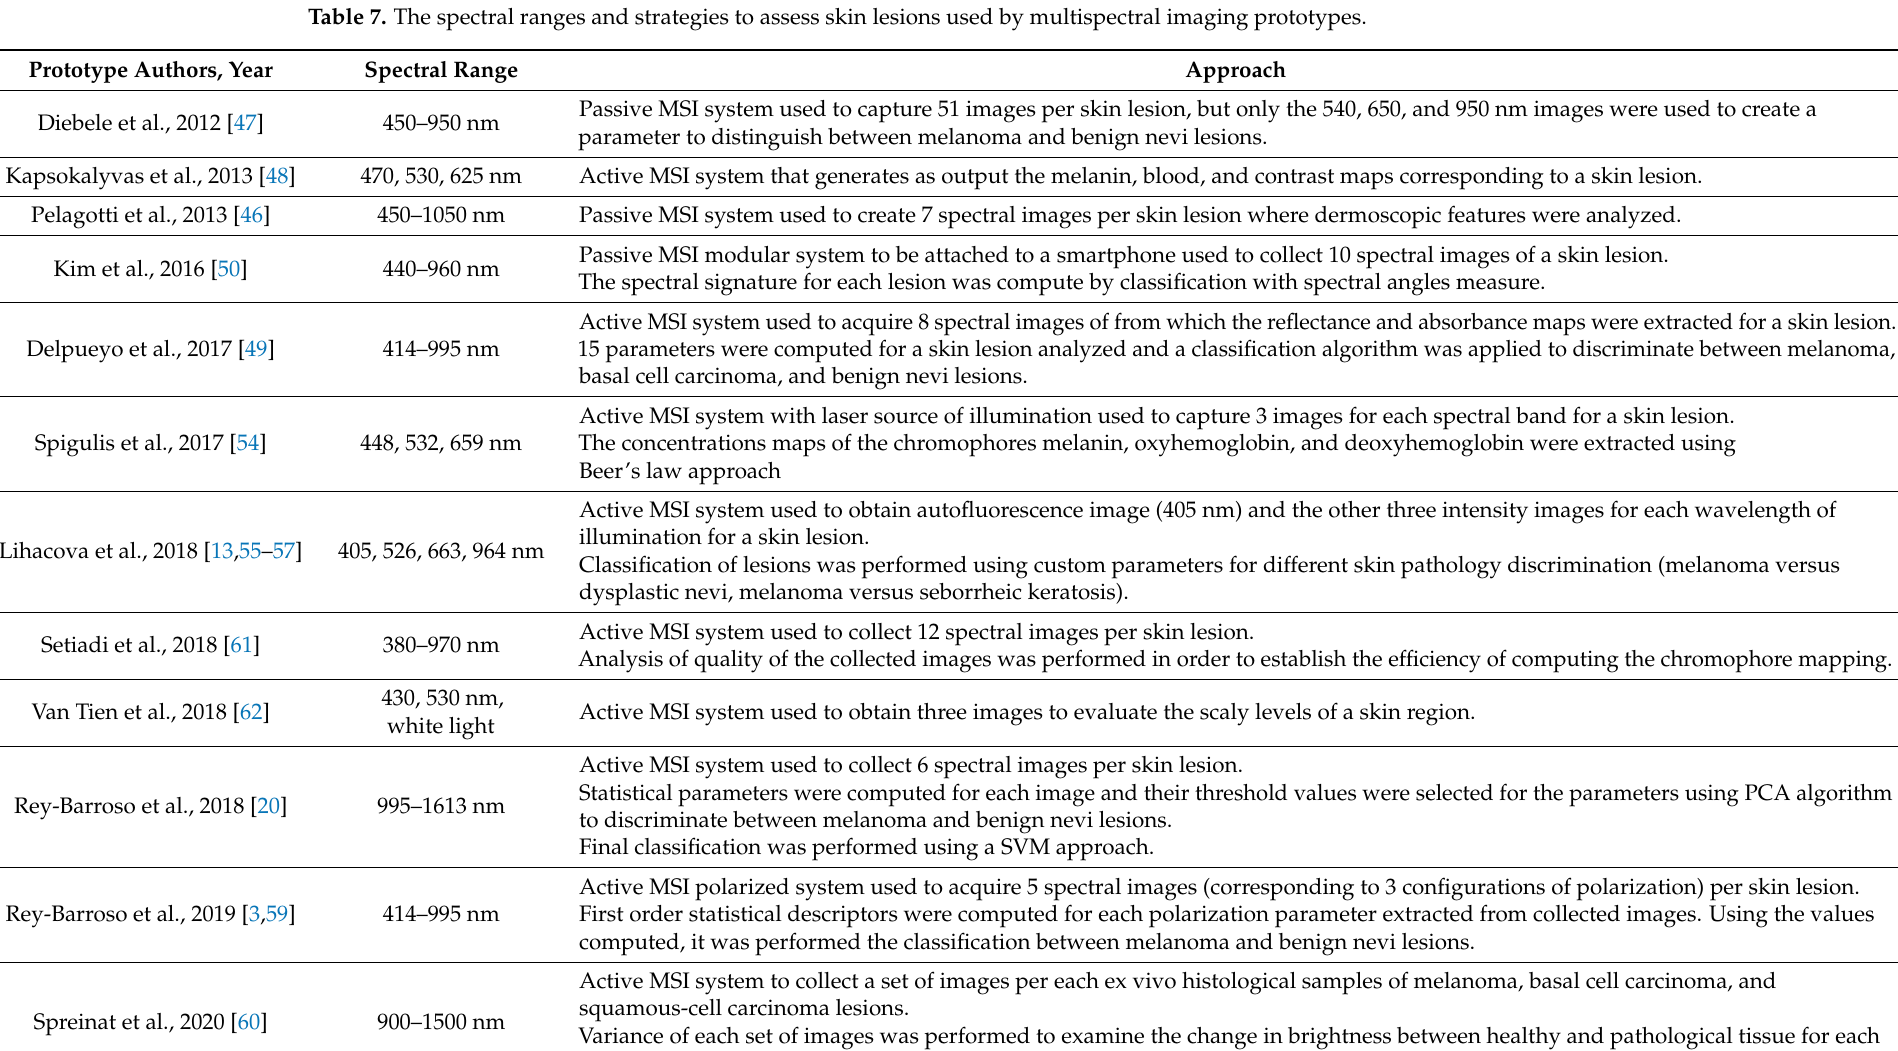
Table 7. The spectral ranges and strategies to assess skin lesions used by multispectral imaging